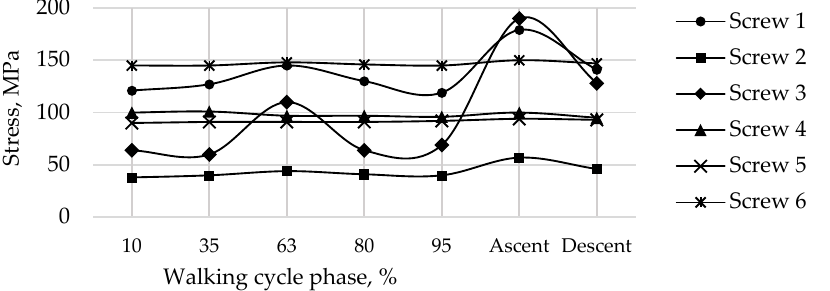
Figure 19. Maximum von Mises stress in each of the screws for a pretension force of 500 N in different phases of the walking cycle.